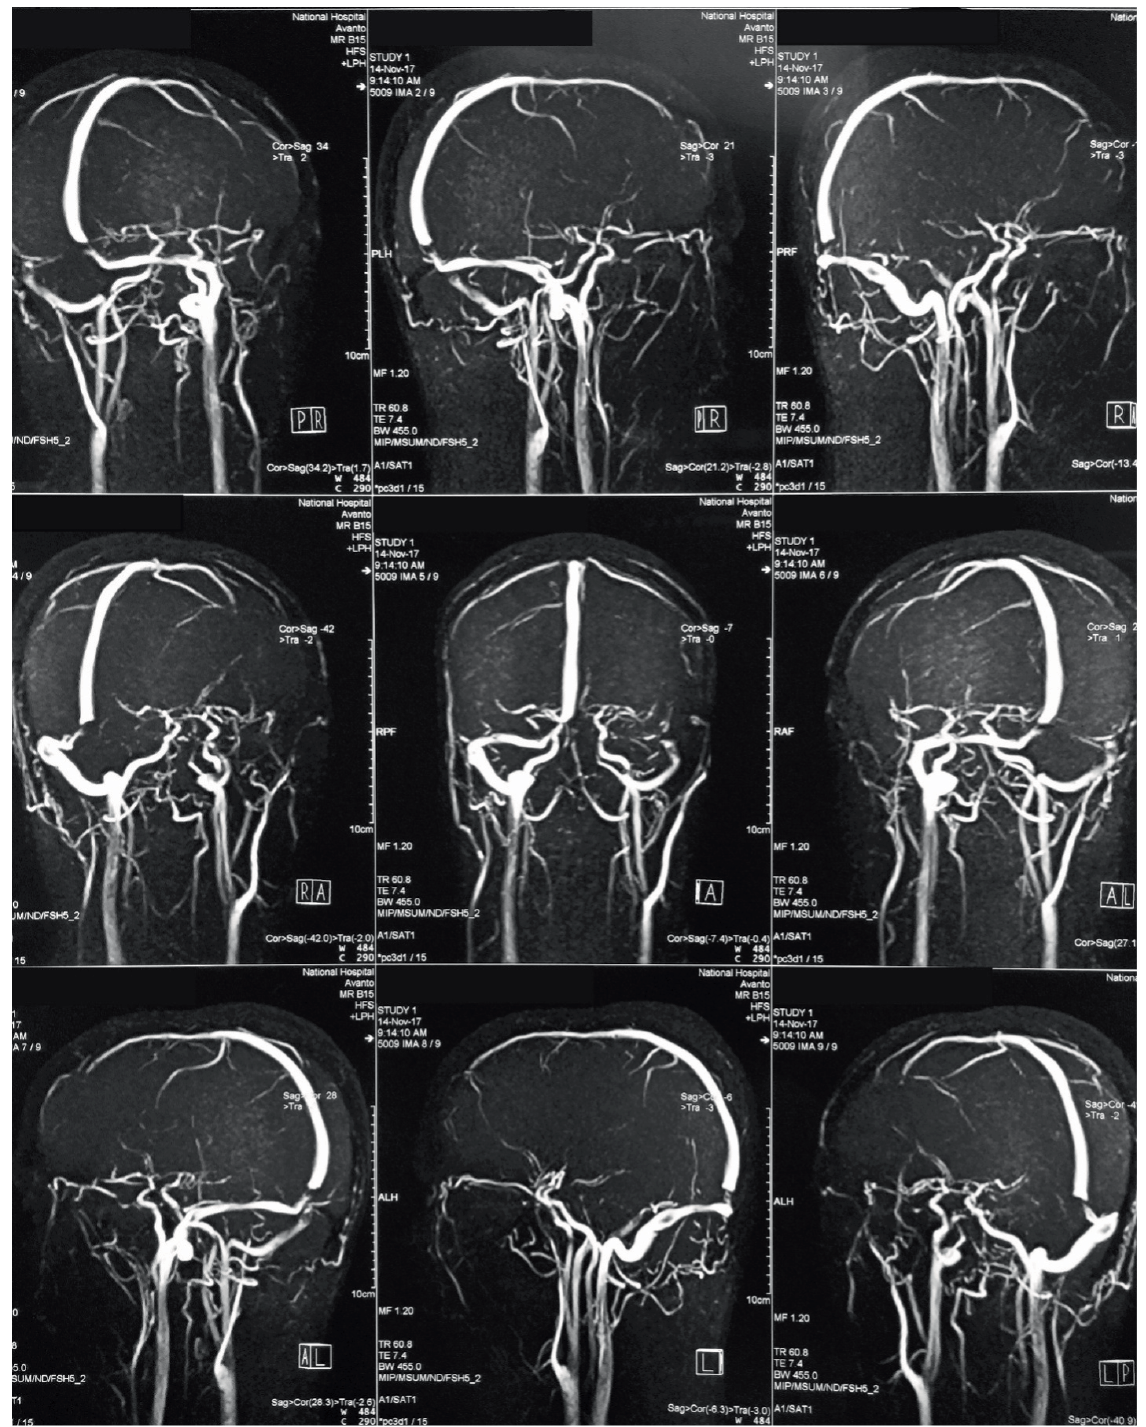
Figure 2: MRV showing thrombosis of the straight sinus, posterior part of superior sagittal sinus and right transverse